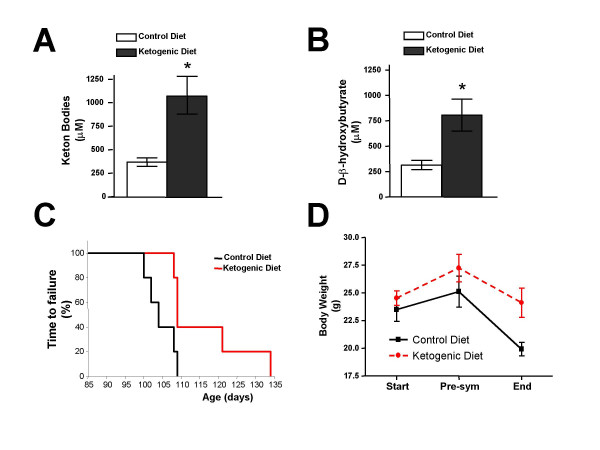
Ketone levels, body weight motor function. (A) The serum content of total ketone bodies (DHB and acetoacetate) in SOD1-G93A transgenic mice. (data = mean ± se; standard diet: n = 5, KD: n = 6; * - p < 0.05). (B) The serum content of DHB in SOD1-G93A transgenic mice. (data = mean ± se; standard diet: n = 5, KD: n = 6; * - p < 0.05). (C) Time to failure (50% baseline performance) in SOD1-G93A transgenic mice fed a KD compared to standard diet from 85 days to 136 days of age. (data = mean ± se; standard diet: n = 5, KD: n = 6; p = 0.027). (D) The effect of the KD on weight in SOD1-G93A mice at the beginning of treatment (Day 50), presymptomatic (Day 89) and endpoint of the study. (data = mean ± se; standard diet: n = 5, KD: n = 6[AV3]; p = 0.047).